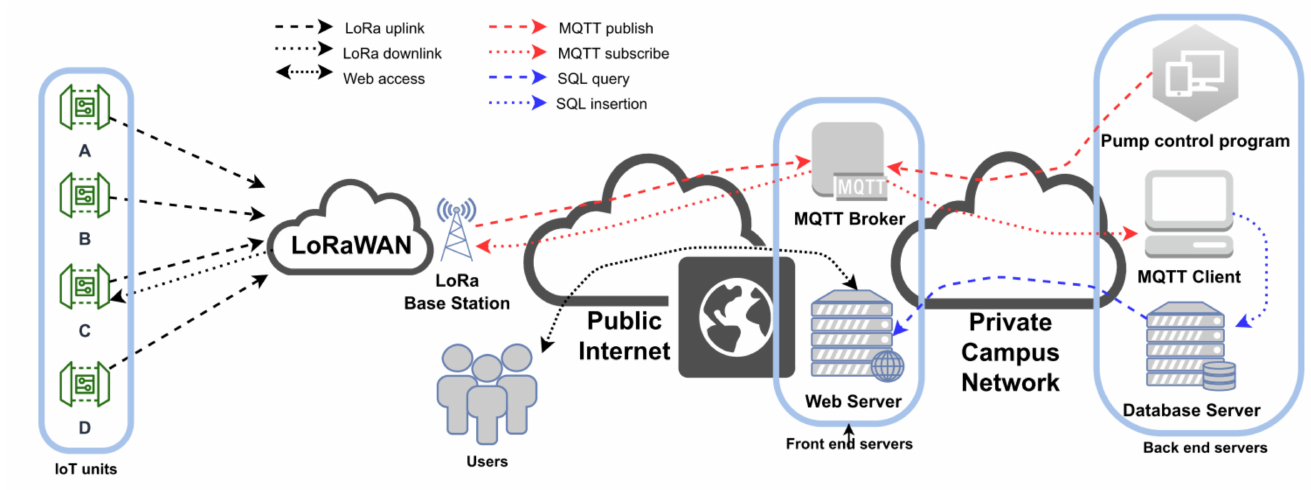
Figure 1. The overall architecture of the proposed LoRa-based multisensor IoT